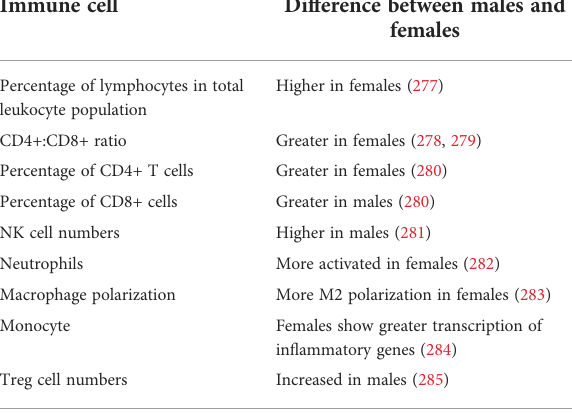
TABLE 8 Sex differences in immune cell numbers and functions. Immune